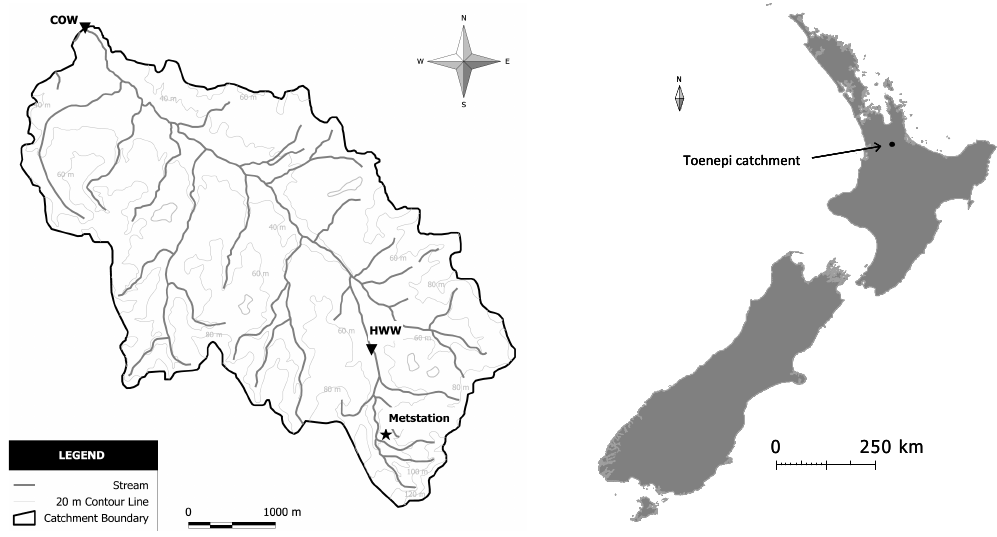
Fig. 3. Map showing Toenepi catchment boundary, 20-m contour lines, and stream sampling sites at the catchment outlet weir (COW) and headwater weir Figure 3. Map showing Toenepi catchment boundary, 20-m contour lines, and stream 6 sampling sites at the catchment outlet weir (COW) and headwater weir (HWW). 7